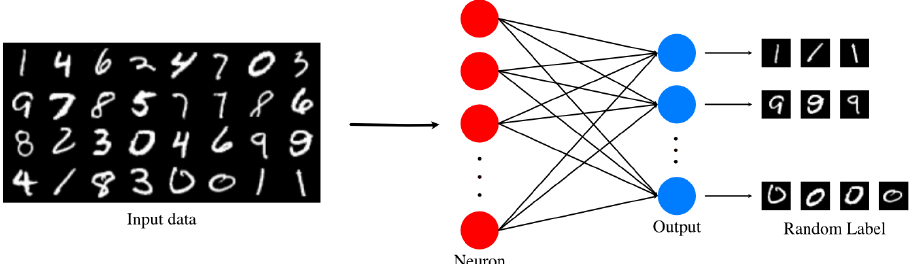
Figure 1. Unsupervised SNN: the input data gone into the network are processed by output neurons and printed out through the synapses connected with the output neurons. The 10 labels in the input data map each of the 10 neurons to a different number. When mapped, the output labels are random rather than sequential in numerical